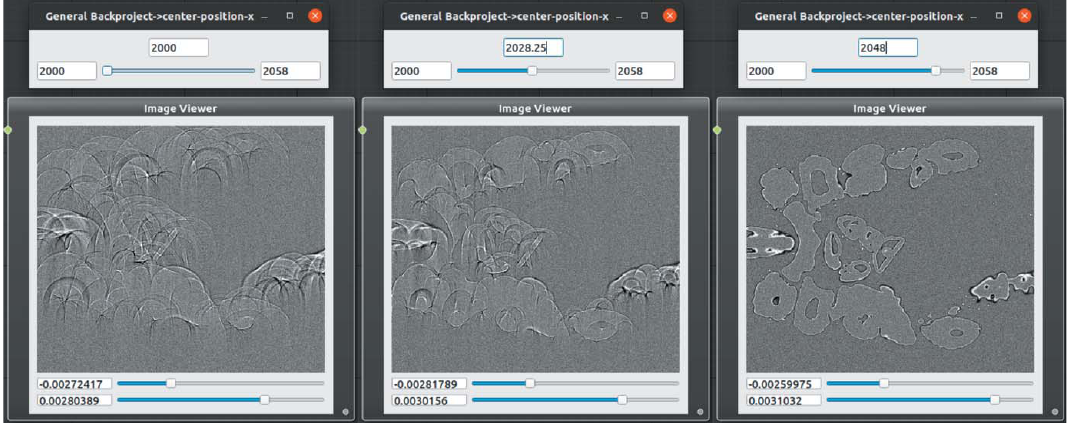
Figure 3 An example of interactive parameter adjustment in tofu flow . The user gradually changes the center of rotation value from 2000 to 2048 by dragging a slider and the updated slice is immediately